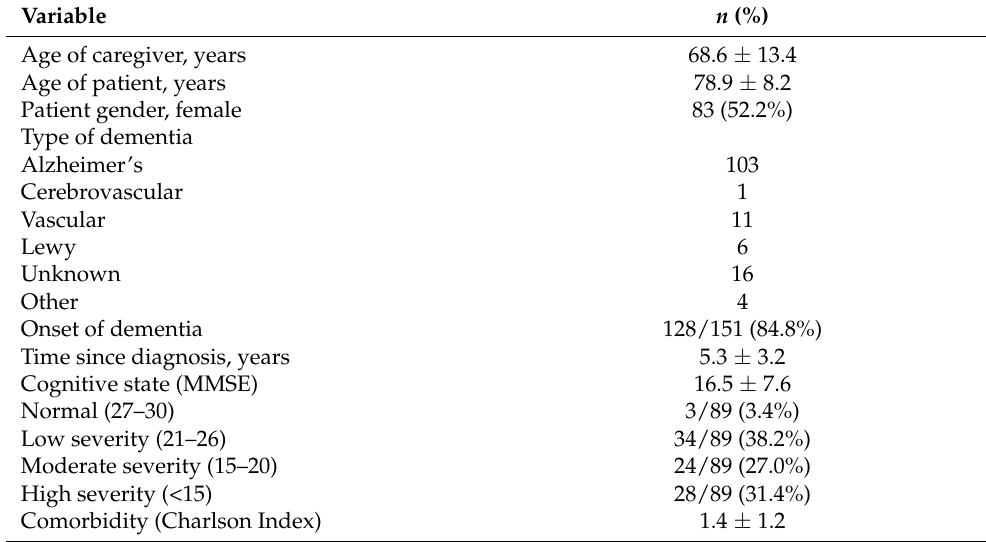
Table 1. Sample characteristics ( n =